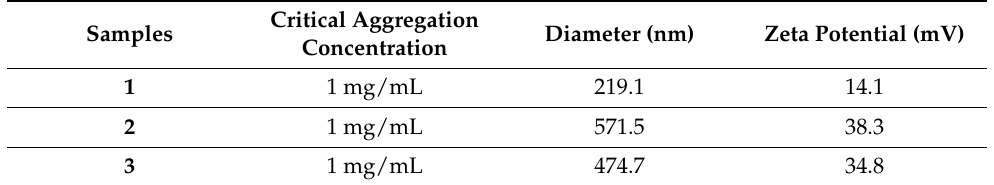
Table 2. Size distribution and Zeta potential of the self-aggregated nanoparticles of chitosan conjugates. Samples